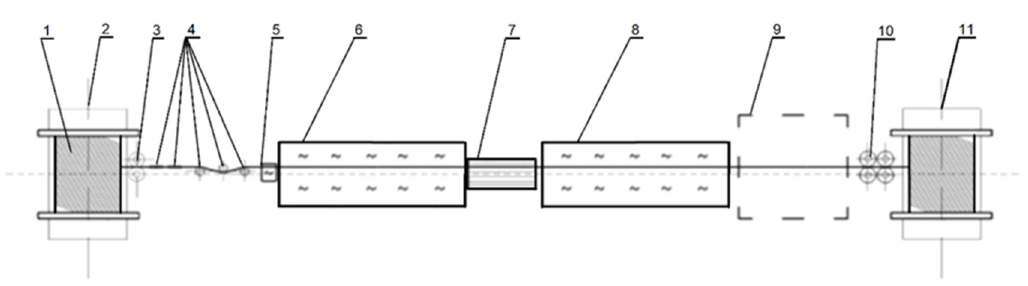
Figure 2. Diagram of a technological line for two-stage heat treatment process for obtaining wires with TRIP structure (1—material; 2—decoiler; 3—drawing rollers; 4—straightening rollers; 5—heating device; 6—high-temperature continuous furnace; 7—continuous cooler; 8—continuous low-temperature furnace; 9—free cooling area; 10—drawing rollers; 11—drum winder). Table 3. Thermally treated wire temperature measurement results for wire speed v = 6.7